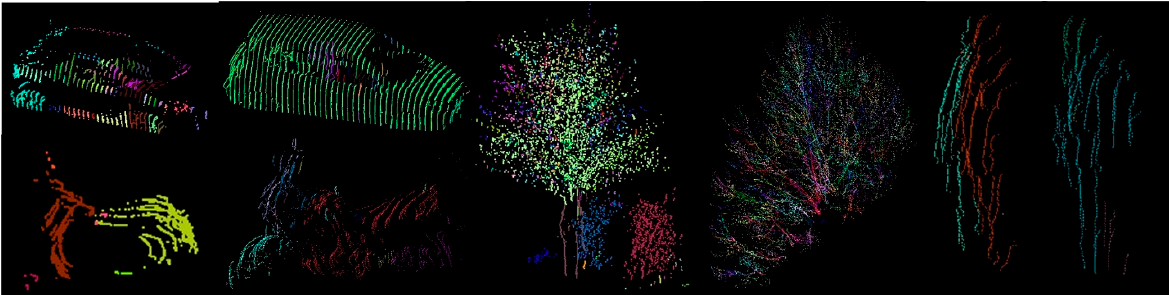
Figure 8. Different structural segment components of the same category in the training dataset.